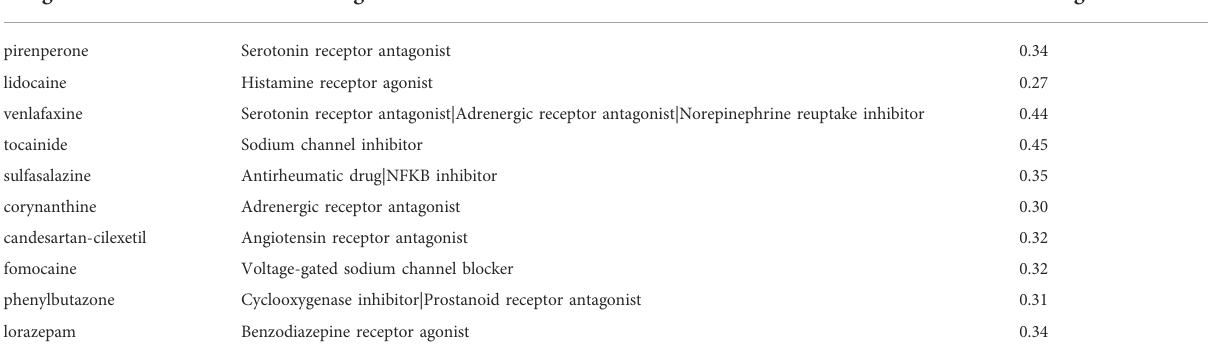
TABLE 1 Summary of predicted CMap